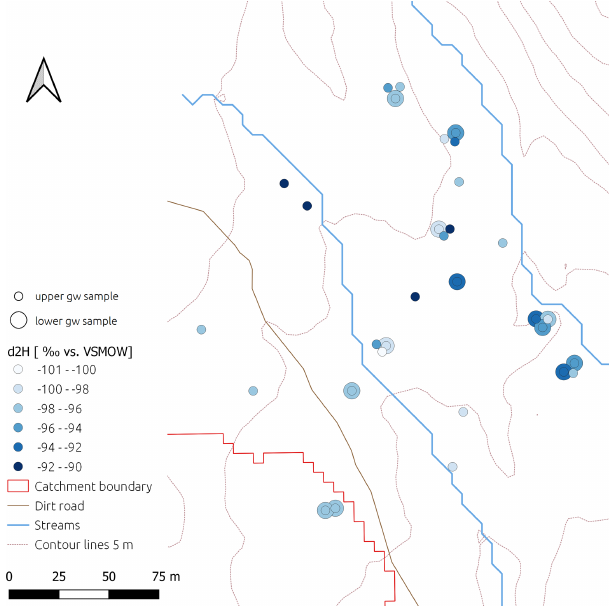
Figure 10. Map of the electric conductivity (EC) of the groundwa- ter samples taken near the water table (small circle; upper ground- water sample) and the bottom of the well (larger circle; lower groundwater sample) for the wells in study area A (also known as the C6 catchment). Where two circles are shown, the outer circle represents the groundwater sample taken from the bottom of the well and the inner circle the groundwater taken near the water table.